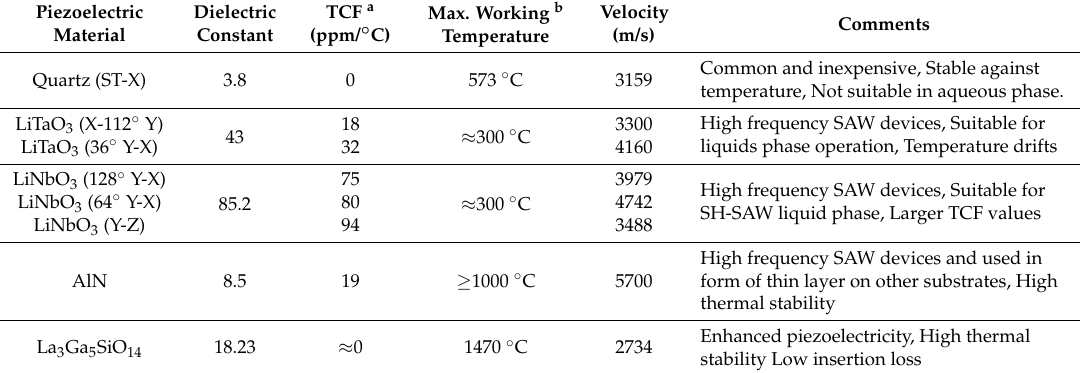
Table 1. Comparison of different piezoelectric materials in terms of their dielectric constants, TCF, SAW propagation velocity and general comments for SAW